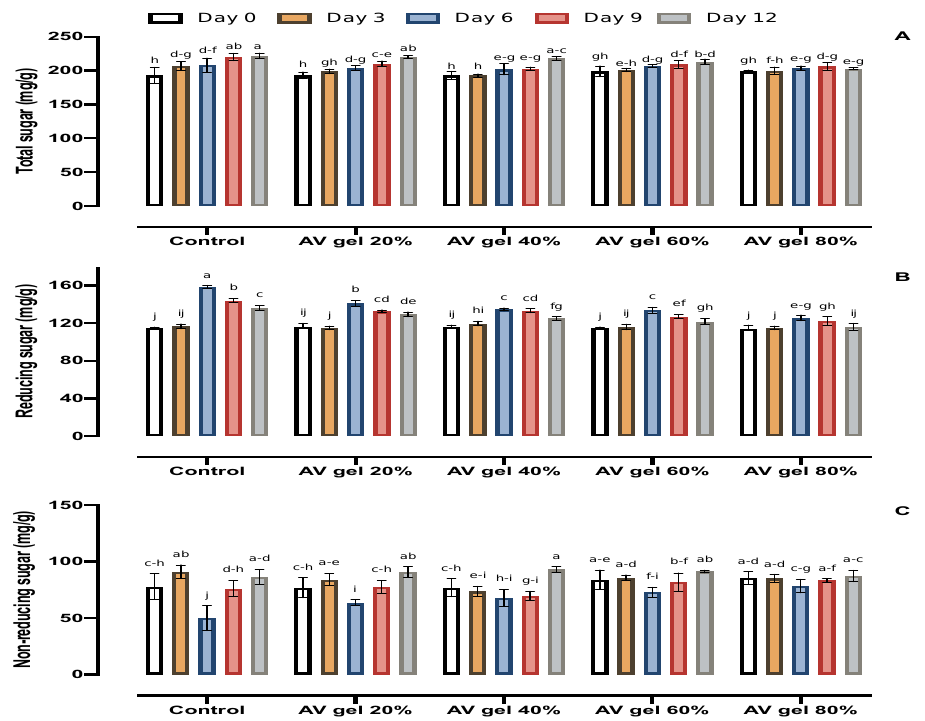
Figure 3. Effects of AV gel coating on total sugars ( A ), reducing sugars ( B ), and non-reducing sugars ( C ) in guava fruit. Standard error shown by vertical bars; each value is the mean of three replicates. Different letters on the top of bars indicate significant differences ( p ≤ 0.05).